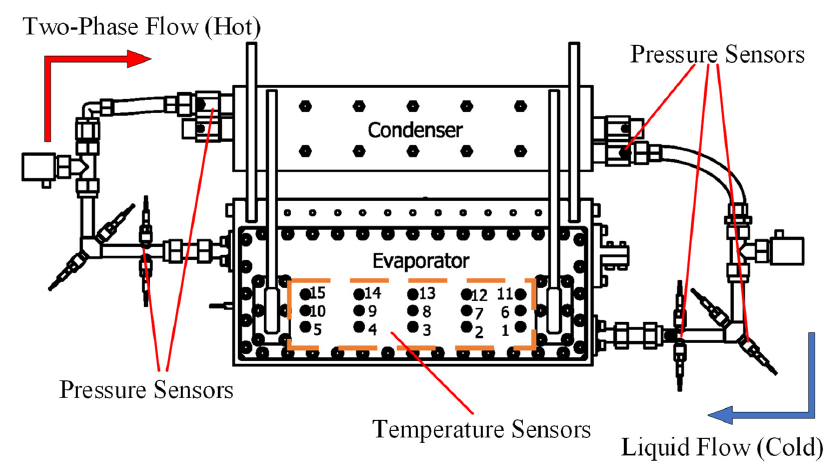
Figure 5. T he distribution of temperature sensors. Figure 5. The distribution of temperature sensors.